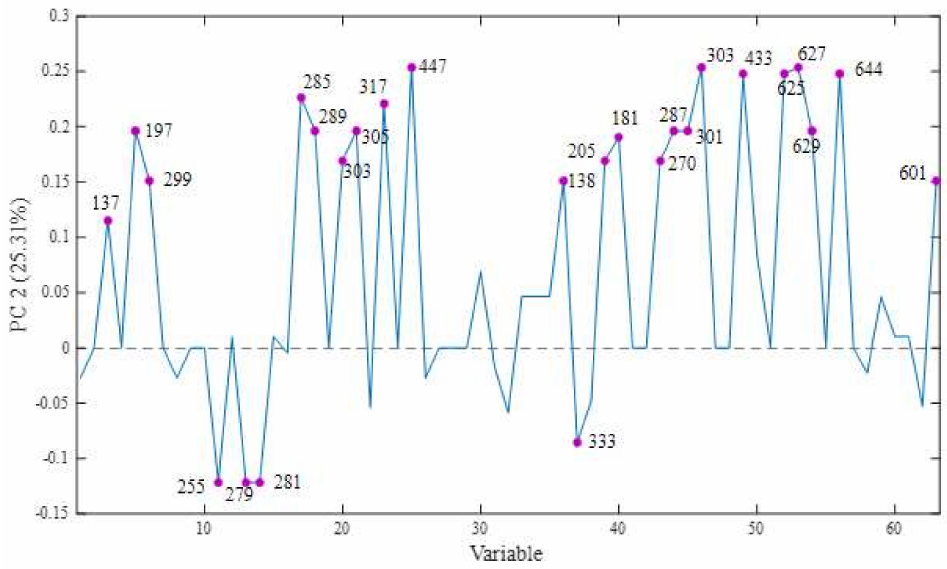
Figure 2. Representation of the loads responsible for the discrimination of the scores of the samples in PC 1 and PC 2.